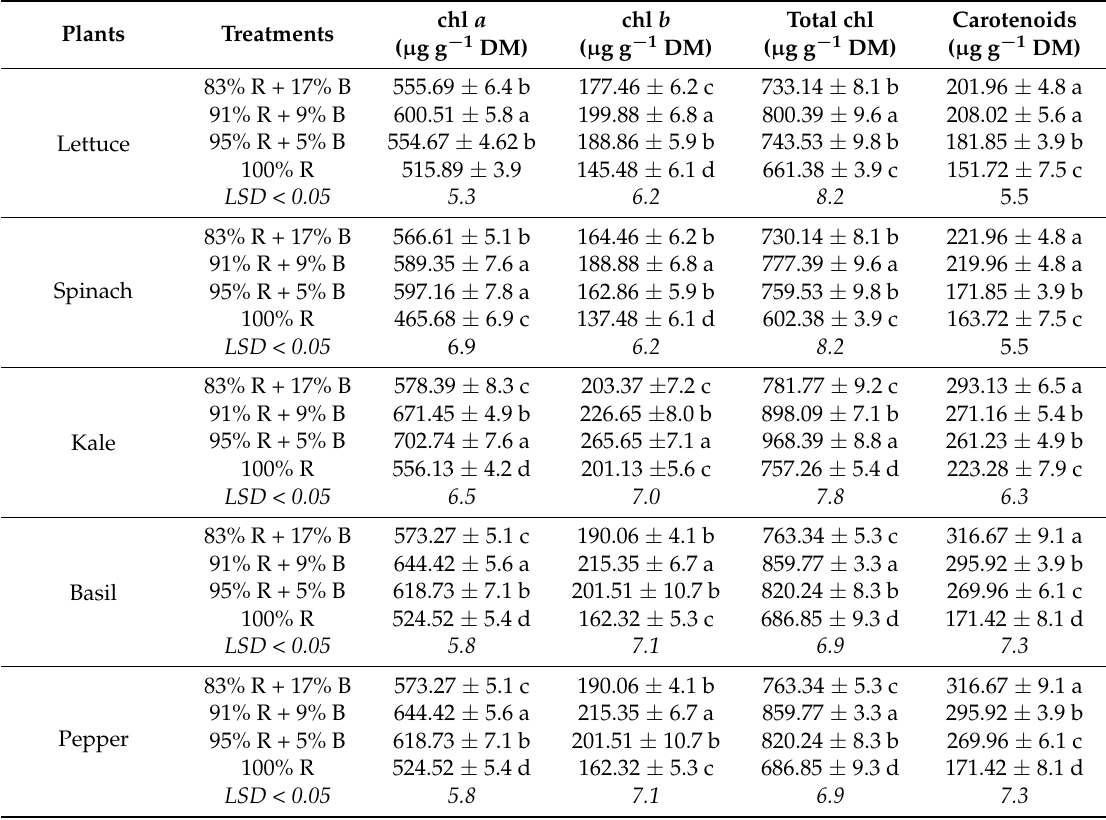
Table 2. The effect of different percentages of red (R) and blue (B) LEDs on chlorophyll a, chlorophyll b, total chlorophyll, and carotenoid content in vegetable